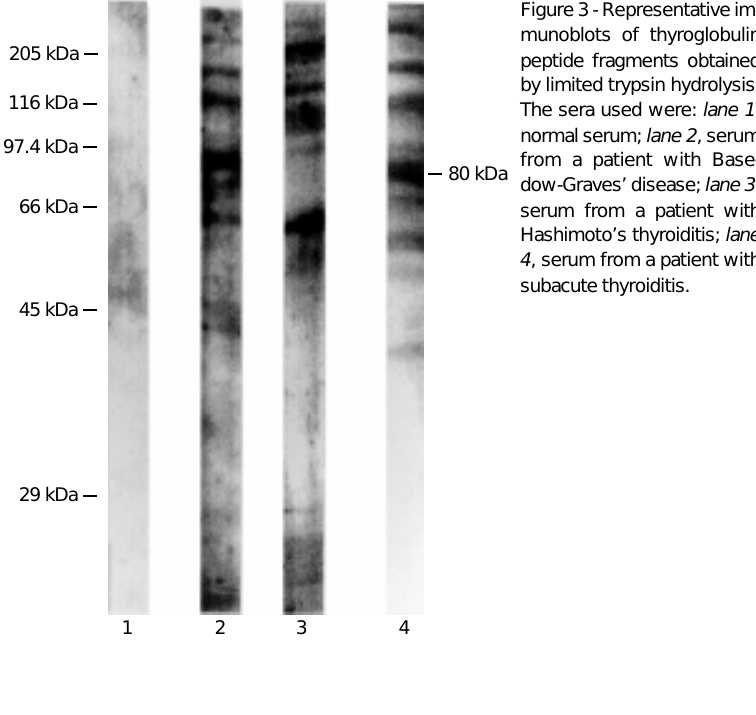
Figure 3 - Representative im- munoblots of thyroglobulin peptide fragments obtained by limited trypsin hydrolysis.